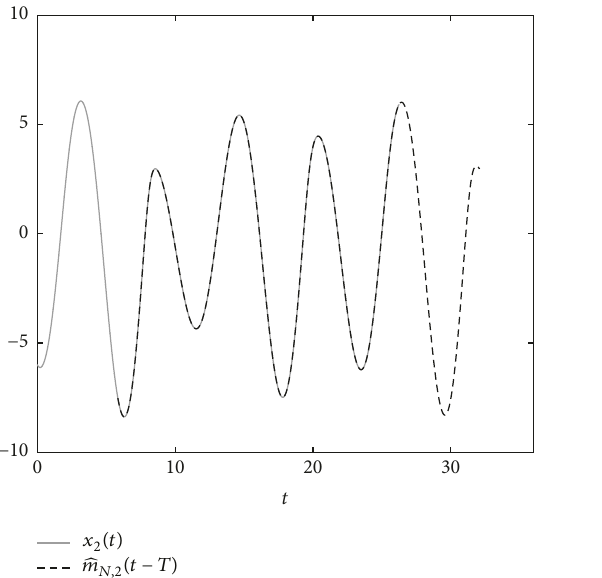
Figure 18: Current time and shifted future time trajectories of the R¨ossler system for 𝑘 = 0 , 𝑘 𝑜 = 10 , and 𝑁 = 102 .